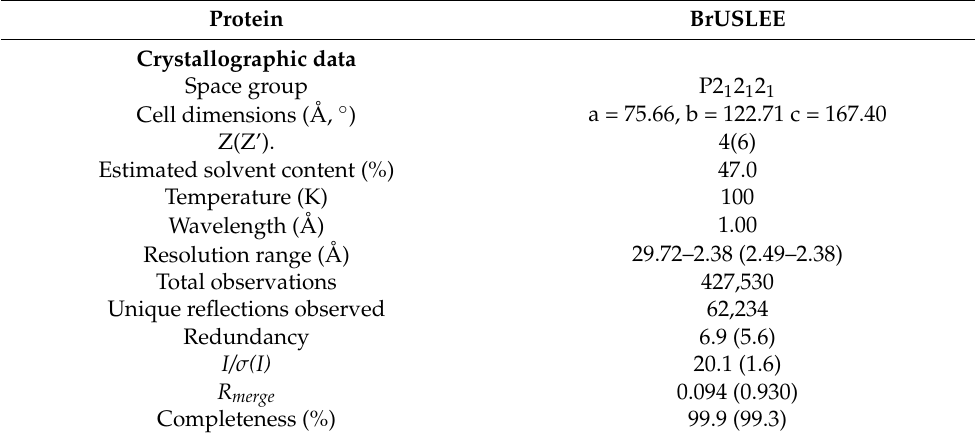
Table 5. Crystallographic data and refinement